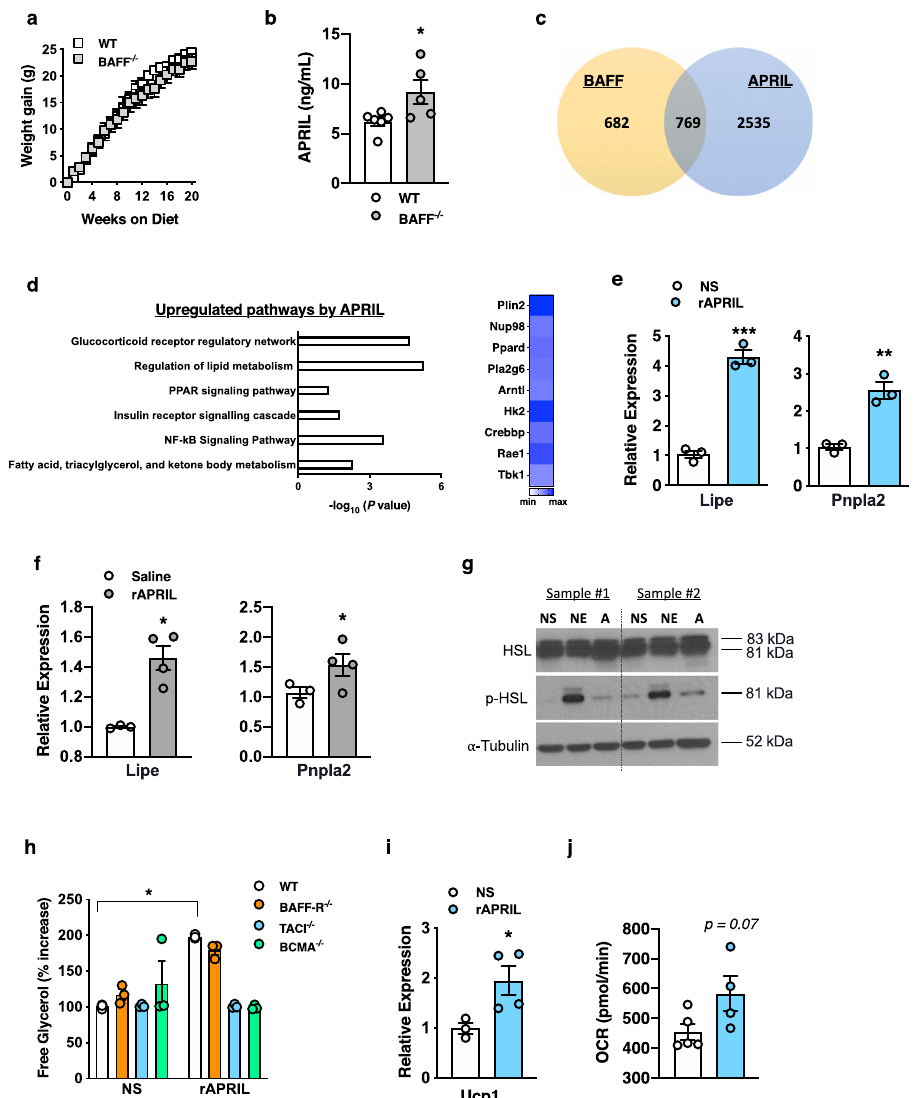
Fig. 4 APRIL modi fi es white adipose lipolysis and brown adipose adaptive thermogenesis. a Weight gain of WT or BAFF − / − mice fed HFD for 20 weeks. b Systemic APRIL concentration in WT or BAFF − / − mice quanti fi ed by ELISA. c – d White adipocytes stimulated in the presence or absence of rBAFF (500 ng/ml), rAPRIL (500 ng/ml), or saline and subjected to RNA-seq analysis. c Venn diagram analysis of genes modi fi ed by BAFF and APRIL. d Ontology pathways and heat map of associated overlapped genes. e qPCR quanti fi ed mRNA expression of indicated lipolysis genes in white adipocytes treated with saline (NS) or rAPRIL (500 ng/ml) for 24 hours. f Lean WT mice treated with rAPRIL (2 μ g/mouse) every other day for 2 weeks. eWAT mRNA expression of indicated lipolysis genes quanti fi ed by qPCR, relative expression to saline-treated controls. g Primary white adipocytes from WT mice were treated with saline (NS), norepinephrine (NE; 1 µ M) or rAPRIL ( a ; 500 ng/ml) for 12 hours. Protein expression of hormone-sensitive lipase (HSL), phosphorlayted HSL (p-HSL), and α -tubulin loading control by western blot. h Free glycerol in supernatants, quanti fi ed by colorimetric assay, of WT, BAFF-R − / − , TACI − / − ,